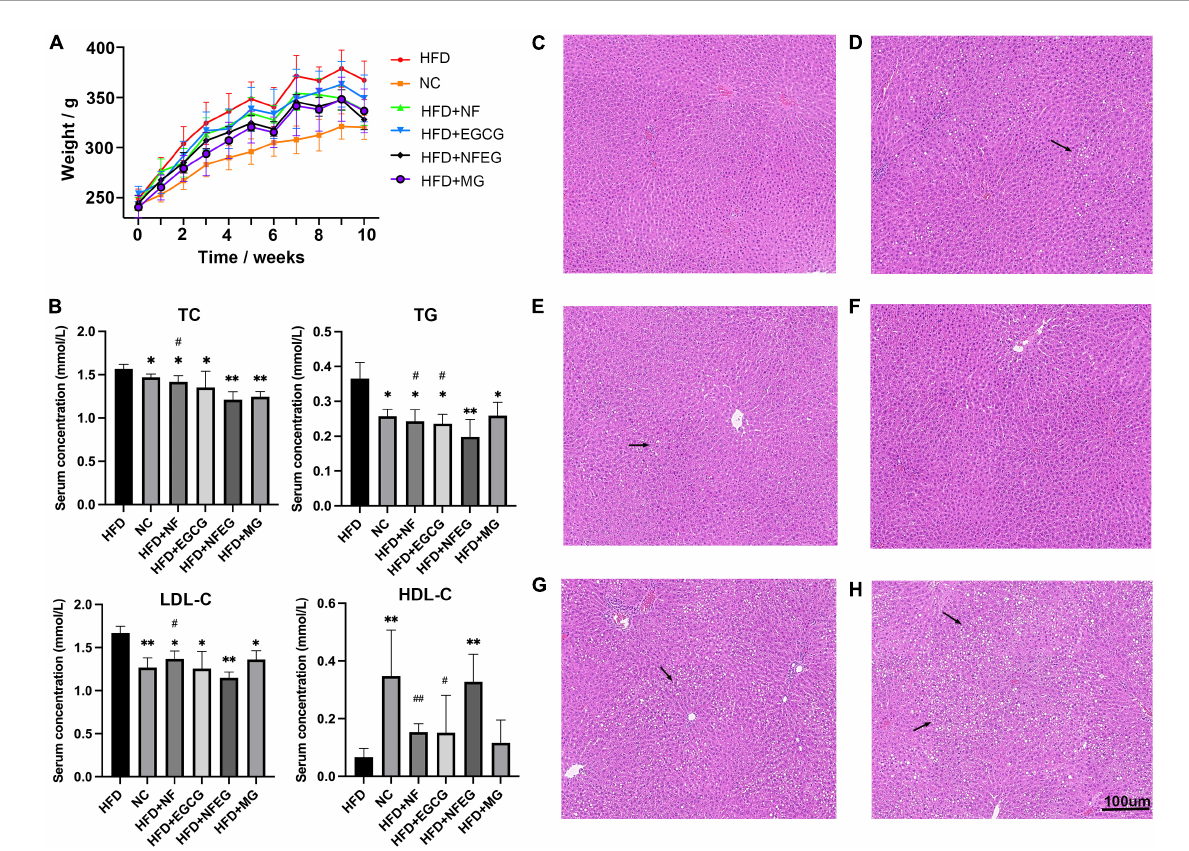
FIGURE2 Body weight, serum biochemical indexes and H&E staining in different treatment groups: (A) body weight of rats, (B) serum TC, TG, LDL-C, and HDL-C concentrations, liver H&E staining (C) NC group, (D) HFD + NF group, (E) HFD + EGCG group, (F) HFD + NFEG group, (G) HFD + MG group, and (H) HFD group. (* P < 0.05) and (** P < 0.01) vs. HFD group; ( # P < 0.05) and ( ## P < 0.01) vs. HFD + NFEG